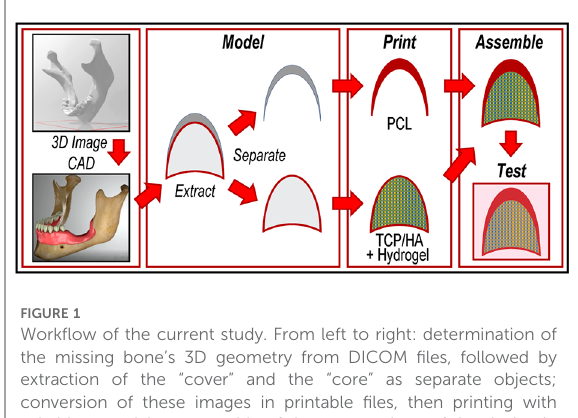
FIGURE 1 Work fl ow of the current study. From left to right: determination of the missing bone ’ s 3D geometry from DICOM fi les, followed by extraction of the “ cover ” and the “ core ” as separate objects; conversion of these images in printable fi les, then printing with suitable materials; reassembly of the two portions of the device in one object, and testing of the construct (by computer